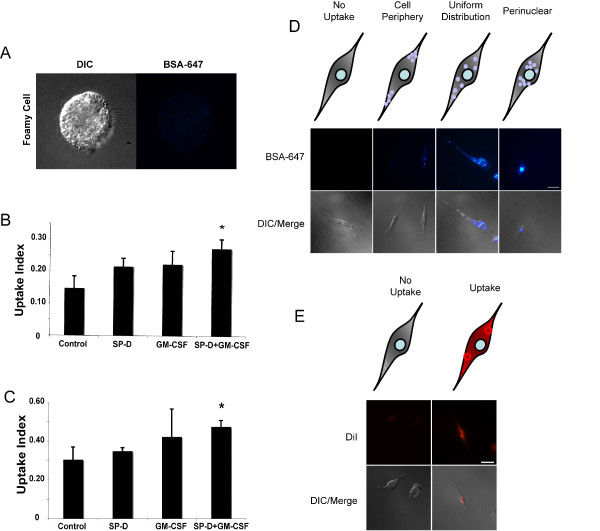
Adherent viable cells isolated from LPI BALF respond to SP-D and GM-CSF and increase uptake of protein and dying cells. (A) LPI BALF contained foamy macrophage cells that did not take up protein. These cells did not survive even an over night culturing, and thus, was not included in the quantification of uptake index. (B) Pre-treatment of primary cells isolated from the BALF with SP-D and GM-CSF facilitate the transport of Alexa-647 conjugated BSA to perinuclear regions. Cells were quantified and presented as means ± SEM of percentage of cells. n = three independent experiments. At least 70 cells were counted for each condition. Uptake index represents the proportion of cells that have Alexa-647 signal in the perinuclear region out of total cell present. The means were compared with respective controls using Dunnett's multiple mean comparison procedure (* p < 0.05). (C) Presence of SP-D and GM-CSF increase the uptake of apoptotic cells by LPI BAL cells. n = three independent experiments. The uptake index represents the proportion of cells that show uptake of apoptotic material out of total cell present. The means were compared with respective controls using Dunnett's multiple mean comparison procedure (* p < 0.05). (D) Representative images showing different categories of cells found 30-min after BSA feeding. (E) Representative images showing the two categories: No uptake; Uptake, where internalized apoptotic bodies/cells were present inside the macrophages.